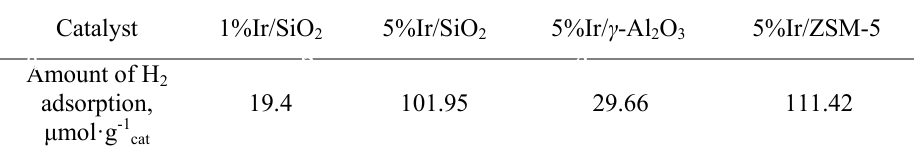
Table 1. Ir dispersion over